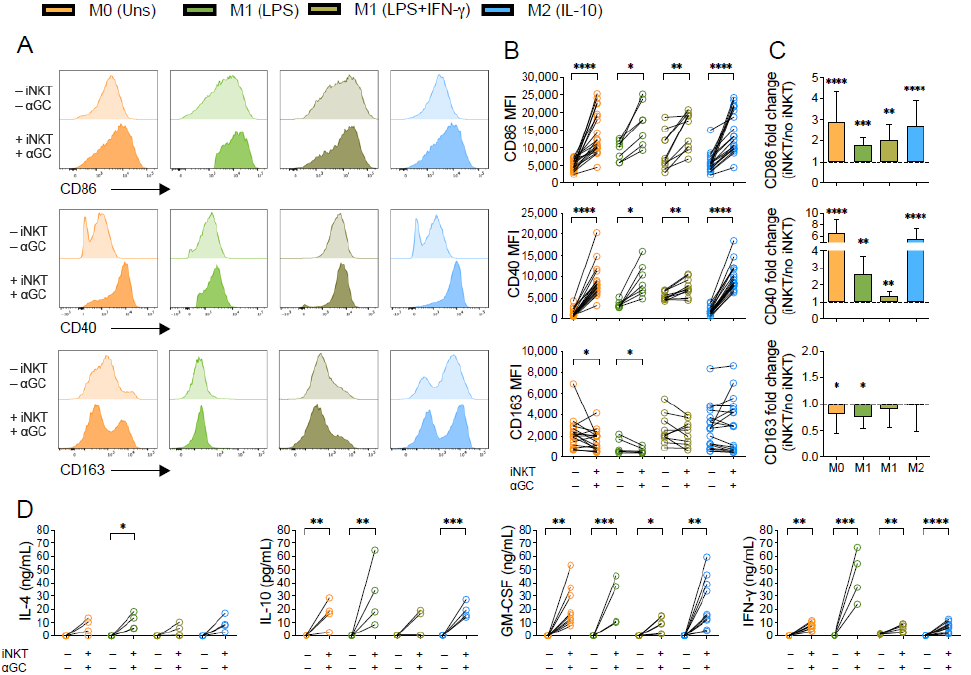
Figure 1. Human macrophages upregulate CD86 and CD40 expression upon co-culture with α - GalCer-activated iNKT cells. M0 (Unstimulated), M1- (LPS- or LPS+IFN- γ -stimulated) and M2-like (IL-10-stimulated) macrophages were co-cultured with or without iNKT cells plus α -GalCer (60 nM) for 18 h. ( A ) Representative flow cytometry plots of CD86, CD40 and CD163 expression on macrophages. ( B ) Mean fluorescence intensity (MFI) of CD86, CD40 and CD163 on macrophages with or without iNKT cells plus α -GalCer. ( C ) Relative macrophage CD86, CD40 and CD163 expression upon co-culture with α -GalCer-activated iNKT cells. Data was normalized to the respective monoculture condition (macrophages alone) for each subject. ( D ) IL-4, IL-10, GM-CSF and IFN- γ concentrations in supernatants from macrophage monocultures and co-cultures with iNKT cells plus α -GalCer. Cytokine levels were measured by ELISA. Data are representative of at least 4 independent experiments. * p < 0.05; ** p < 0.01; *** p < 0.001; **** p < 0.0001. ( B ) Wilcoxon test, ( C ) One-sample t-test ( D ) Paired t -test or Wilcoxon test.